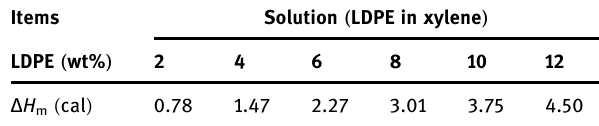
Table 2: The enthalpy of the di ff erent concentrations of the LDPE solvent